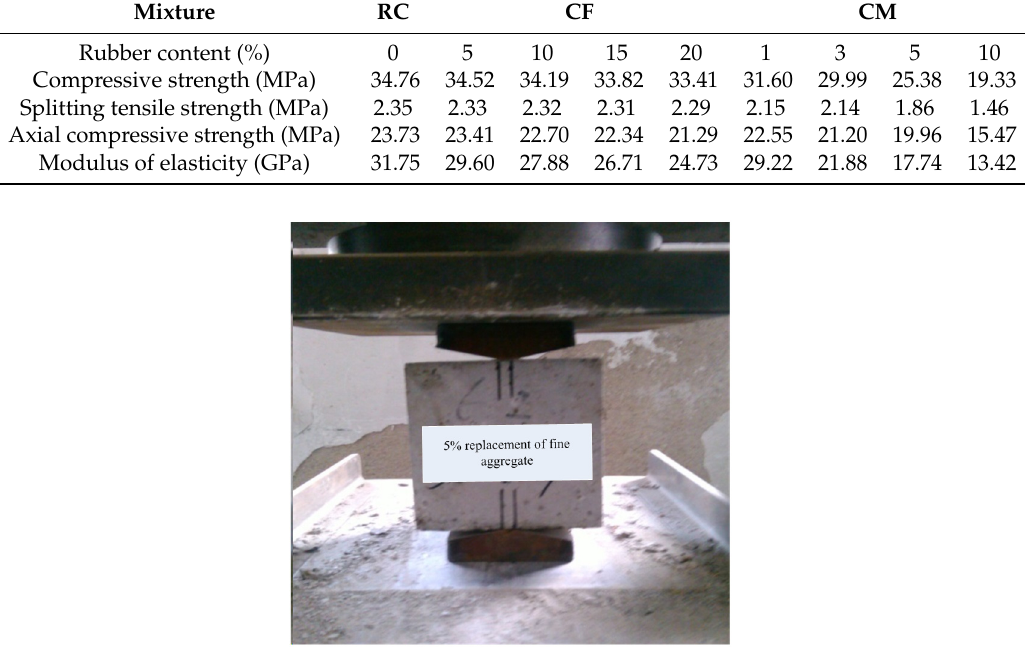
Fig ure 4. Splitting tensile strength test. Figure 4. Splitting tensile strength